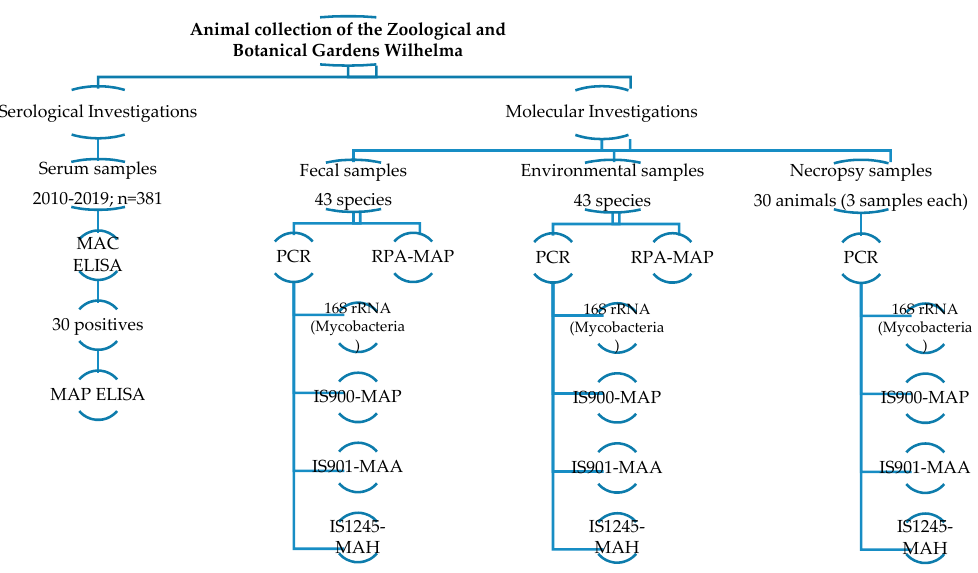
Figure 1. Flow chart of the methods used to screen the collected samples.